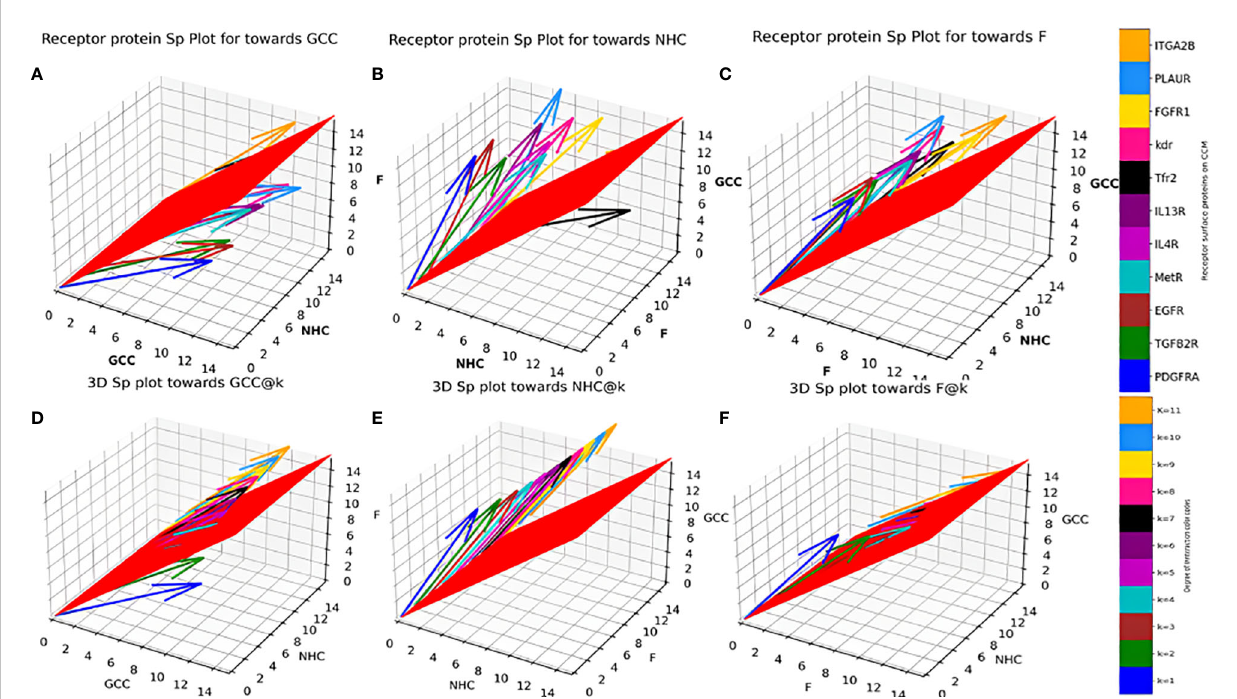
FIGURE 3 Individual Protein vs Degree of interaction quiver plots; 3D S_p plot for Individual surface proteins towards (A) GCC, (B) NHC and (C) F; 3D S_p plot @k interactions towards (D) GCC, (E) NHC and (F) F.